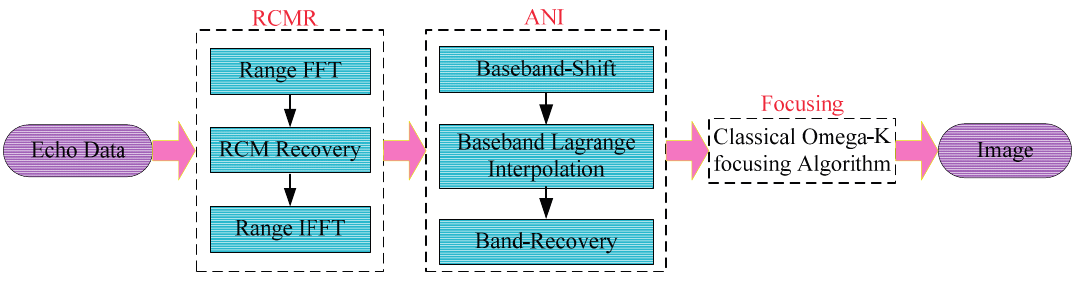
Figure 5. Processing details of the traditional imaging algorithm for staggered